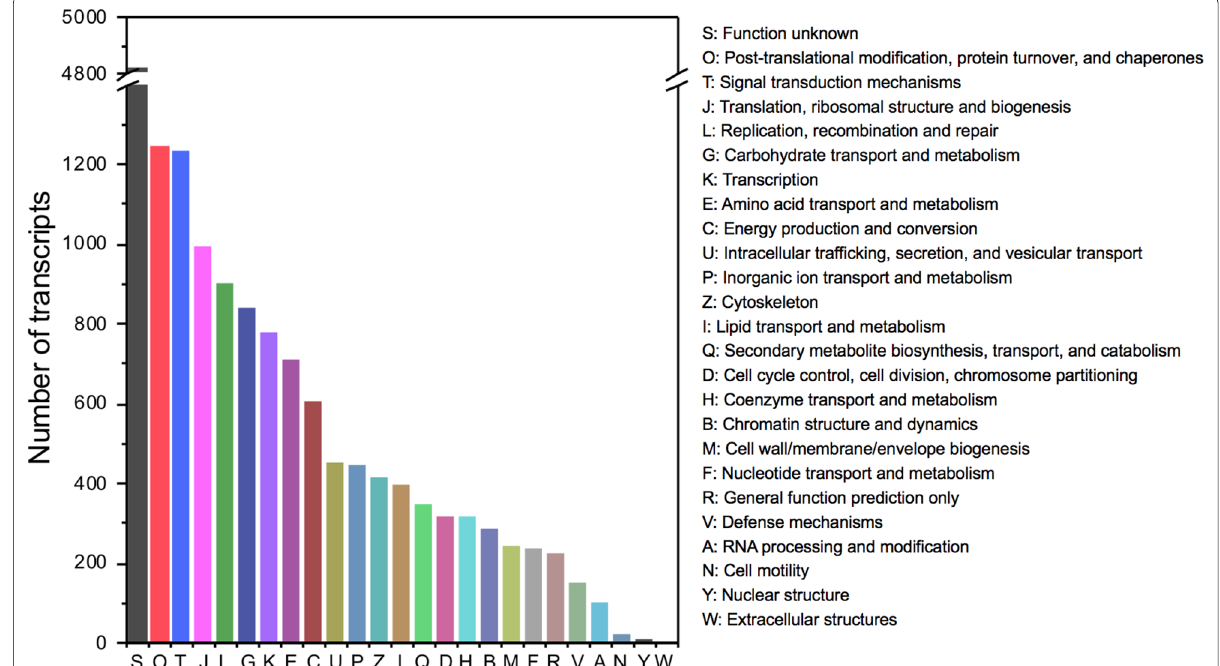
Fig. 1 COG functional classification of transcripts of S. mycoparasitica . The functions of 15,346 transcripts were predicted and classified into 25 categories (indicated by the alphabetical notations) in descending order through the Clusters of Orthologous Groups (COG)